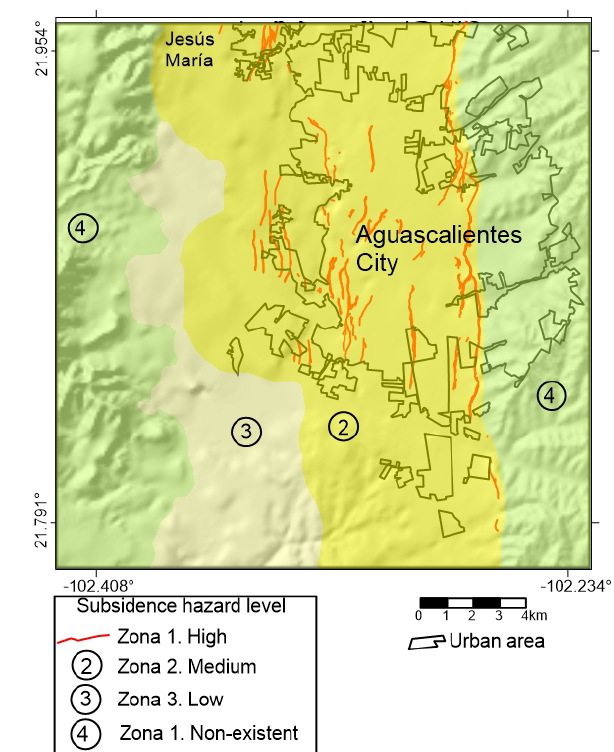
Figure 7. Subsidence hazard zoning map of Aguascalientes City.